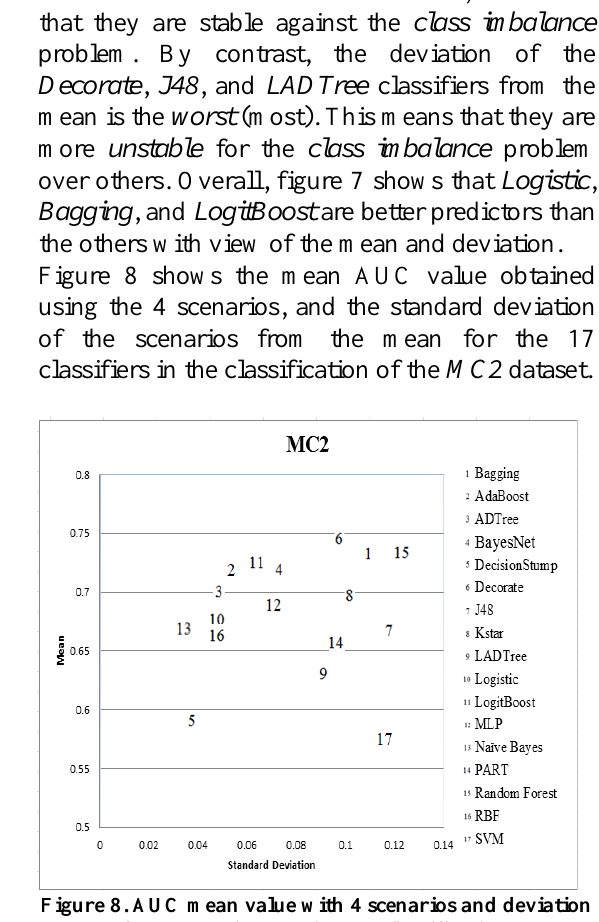
Table 3. Performance of classifiers under scenarios.